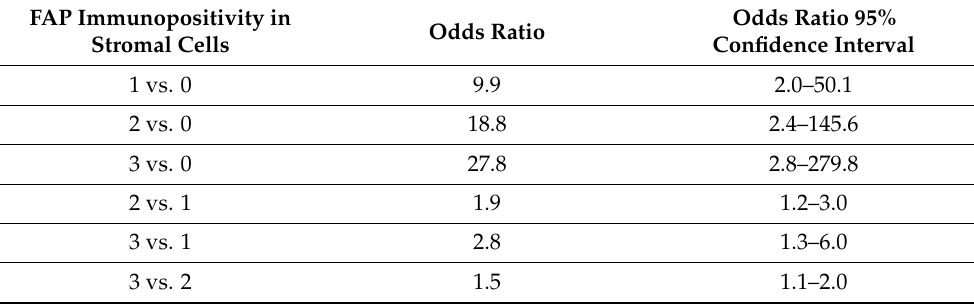
Table 3. FAP expression in stromal cells is associated with a higher probability of progression at six months in glioblastoma. Estimated odds ratios and 95% confidence intervals for the presence of tumour progression at six months for tumours with differing FAP immunopositivity in stromal cells. Odds Ratio 95% FAP Immunopositivity in Odds Ratio Confidence Interval Stromal Cells 1 vs.